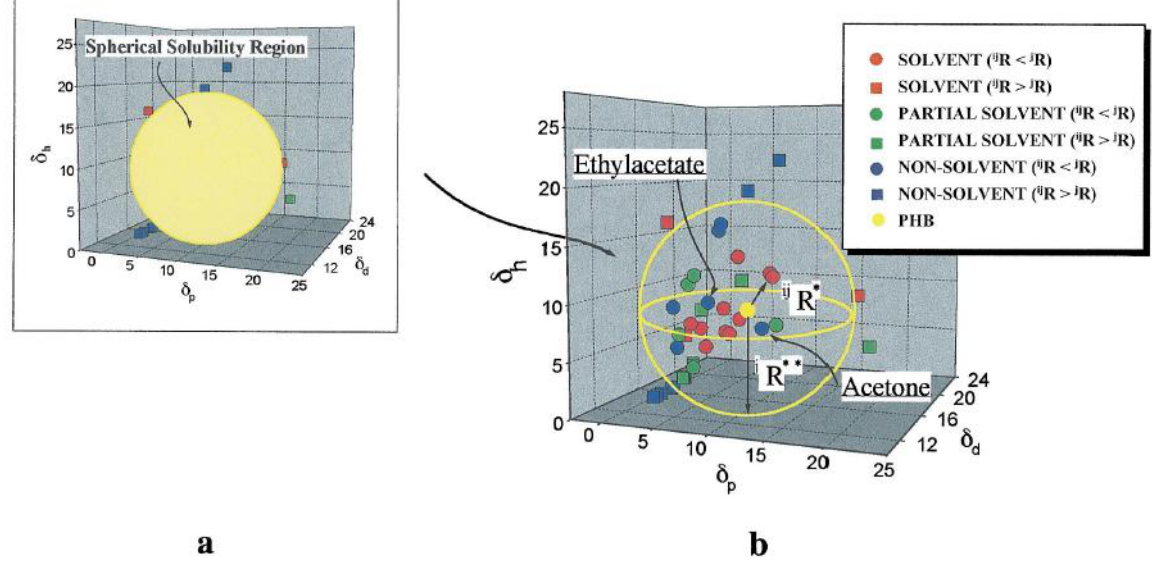
Figure 3. Spherical region characterizing poly(3-hydroxybutyrate) (PHB) solubility in various solvents: ( a ) the outline of the region; and ( b ) the inside of the region. The shapes indicating the solvents depend on whether the point is located inside or outside the solubility region: square and circle represent a position outside the region ( j R < ij R) and one inside the region ( j R > ij R), respectively. ij R, distance of solvents at position ( δ from center of solubility sphere for PHB, calculated from Equation (4). (Reprinted from [45], Copyright 1999, with permission from